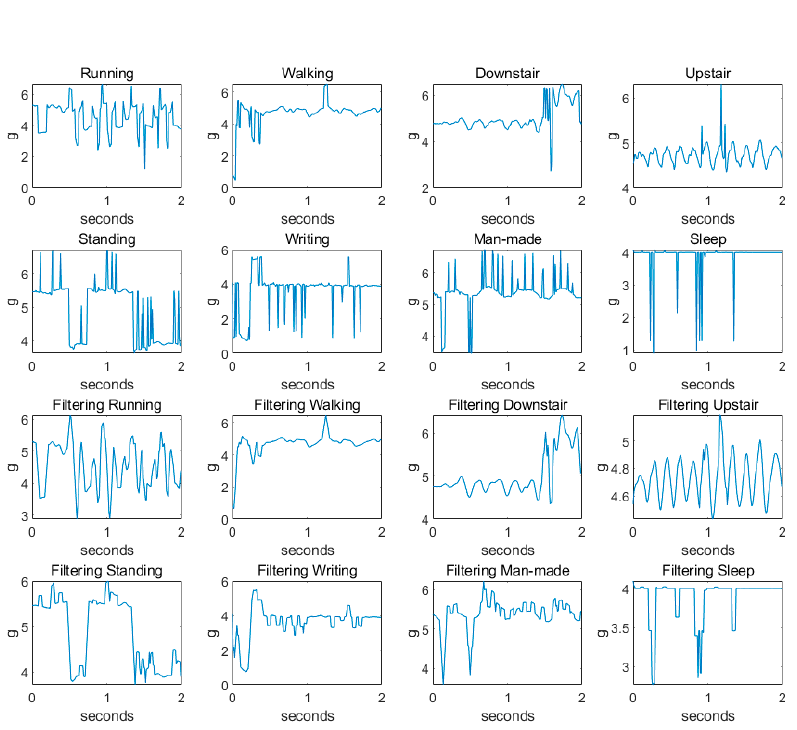
Figure 3. Acceleration signal after acceleration synthesis and filtering.